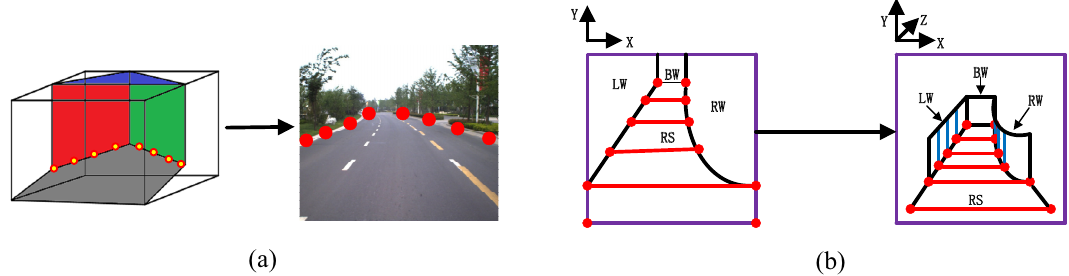
Figure 6. Generation of control points. (a) labeling of control points; ( b ) scene modeling results.